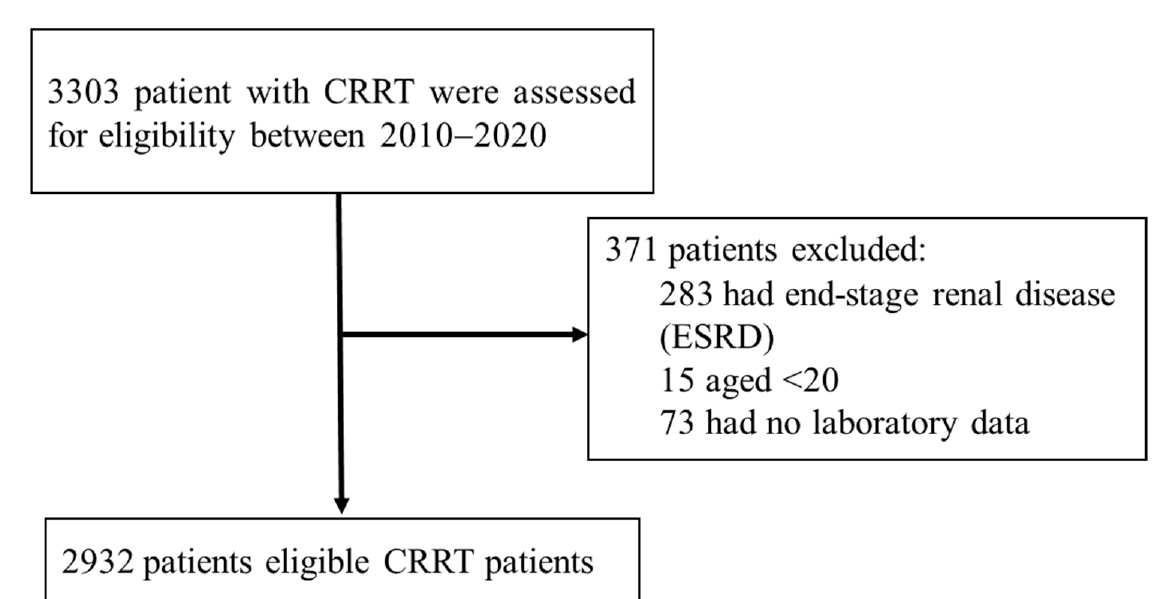
Figure 1. Flow chart of study patients.